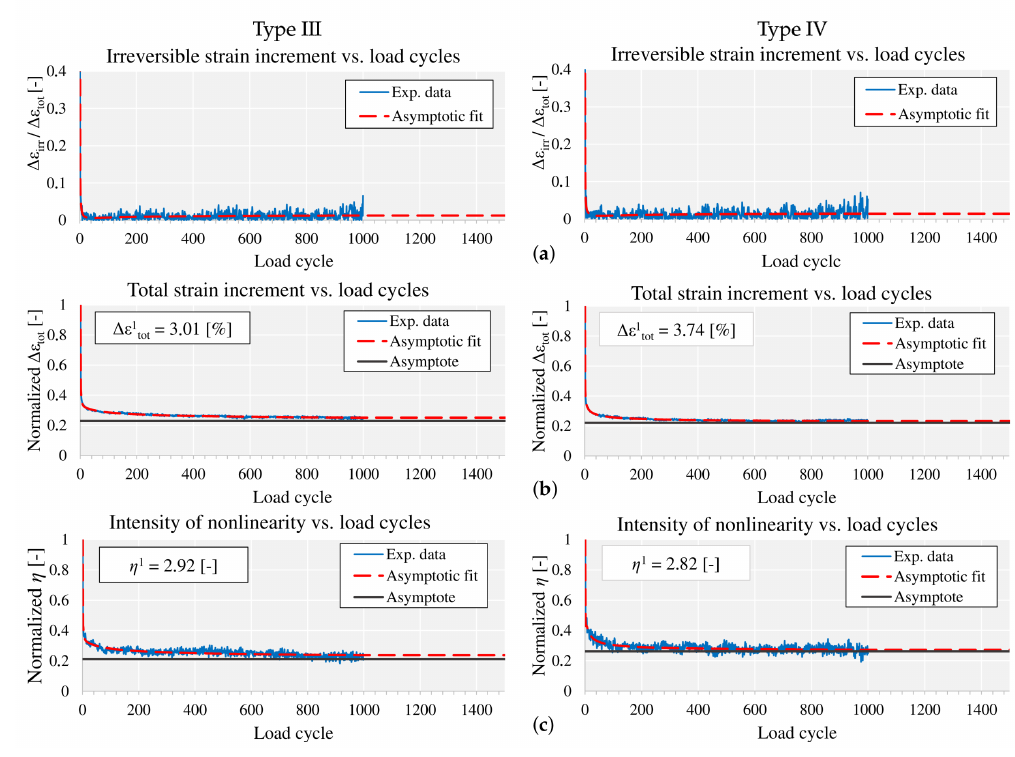
Figure 2. Representative curves of the inspection characteristics for the investigated glass-polytetrafluoroethylene (PTFE) fabric types III and IV: ( a ) irreversible strain increment; ( b ) total strain increment; ( c ) intensity of